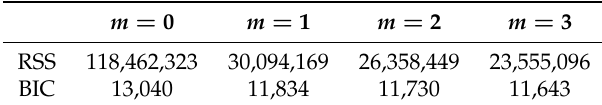
Table 2. RSS and BIC scores for the Bai–Perron test.